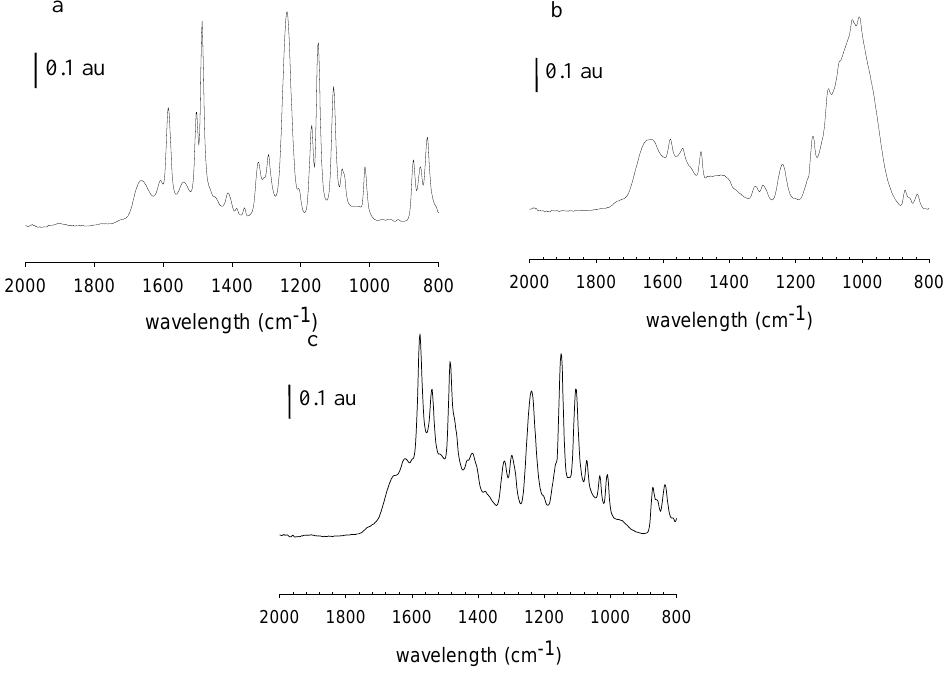
Figure 6. FTIR of ( a ) pristine MPF-34 membrane; ( b ) fouled MPF-34 membrane; ( c ) cleaned MPF-34 membrane.